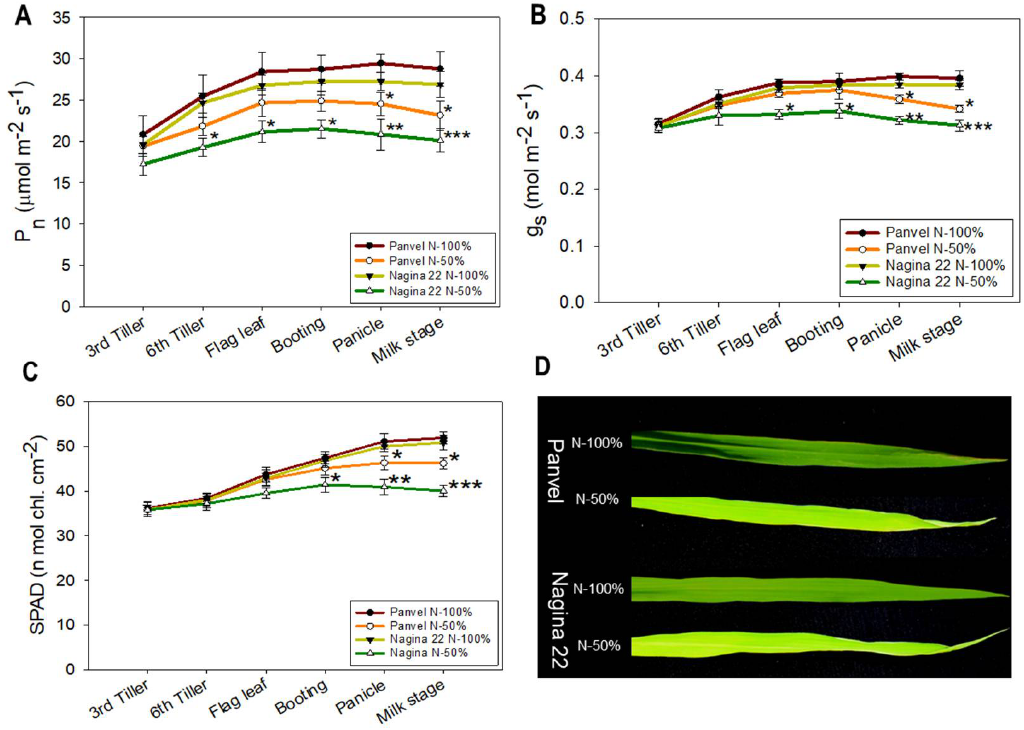
Figure 2. Changes in gas–exchange traits at N–50% treatment in Panvel and Nagina 22 rice cultivars rather than N–100% treatment. P n = net photosynthetic rate ( A ), g s = stomatal conductance ( B ), chlorophyll content measured by SPAD ( C ), and leaves of rice plants at the panicle growth stage ( D ). Each curve point in each graph represents the mean ± SE at each growth stage, and the asterisks denote the significant differences at * p < 0.05, ** p < 0.01, and *** p < 0.001 between the treatments of each